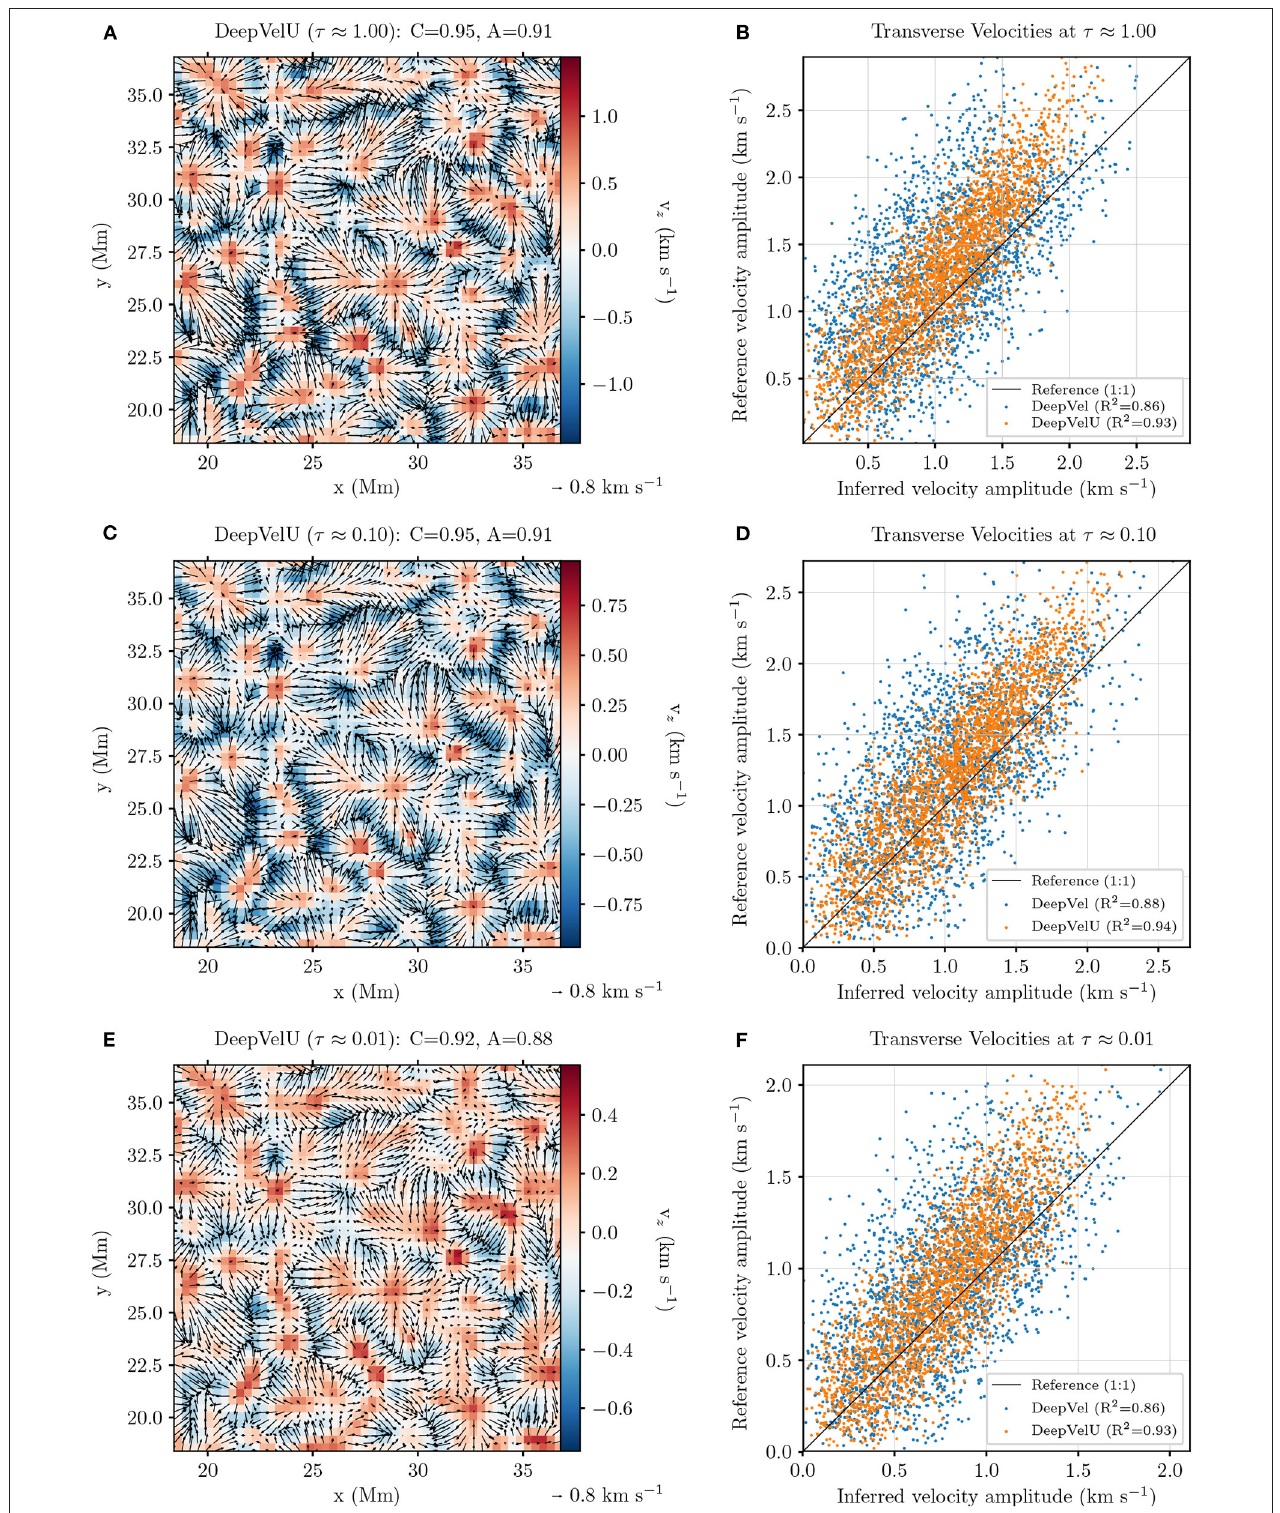
FIGURE 1 | (Left) Patches of 50 by 50 pixels 2 extracted from the 30-timestep-averaged transverse velocity fields E v D , t inferred by DeepVelU at optical depths (A) τ ≈ 1, (C) τ ≈ 0.1, and (E) τ ≈ 0.01. The 30-timestep-averaged vertical velocity v z ,ref ( τ ≈ { 1,0.1,0.01 } ) computed by the STAGGER simulation and resampled to the SDO/HMI resolution is displayed as background (colorscale). (Right) Scatterplots comparing amplitudes |E v D, t | to |E v ref, t | at optical depths (B) τ ≈ 1, (D) τ ≈ 0.1, and (F) τ ≈ 0.01. The black line represents the expected solution (i.e., a coefficient of determination R 2 = 1).